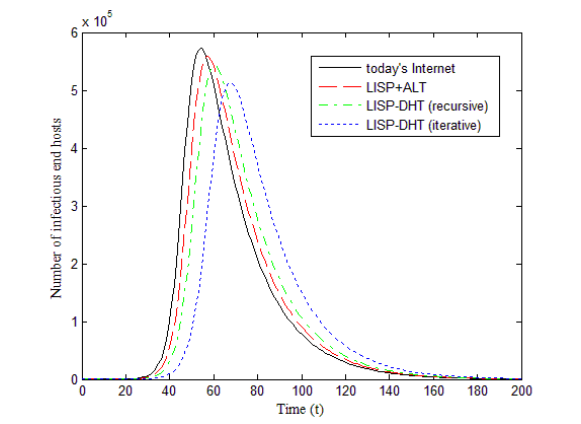
Fig. 5. Number of infectious end hosts with different mapping